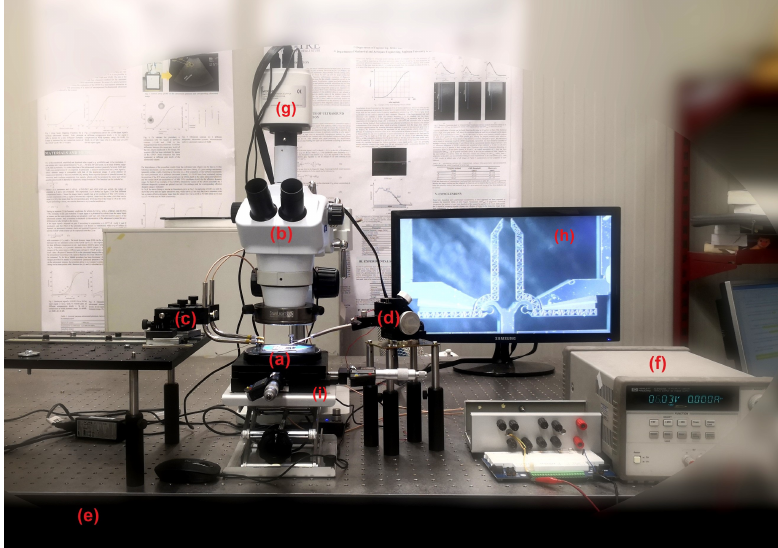
Figure 2. Experimental setup: microgripper ( a ), optical microscope ( b ), micropositioners with embedded probe arms and tungsten needles ( c ), micropositioner with spoon-shaped metal probe ( d